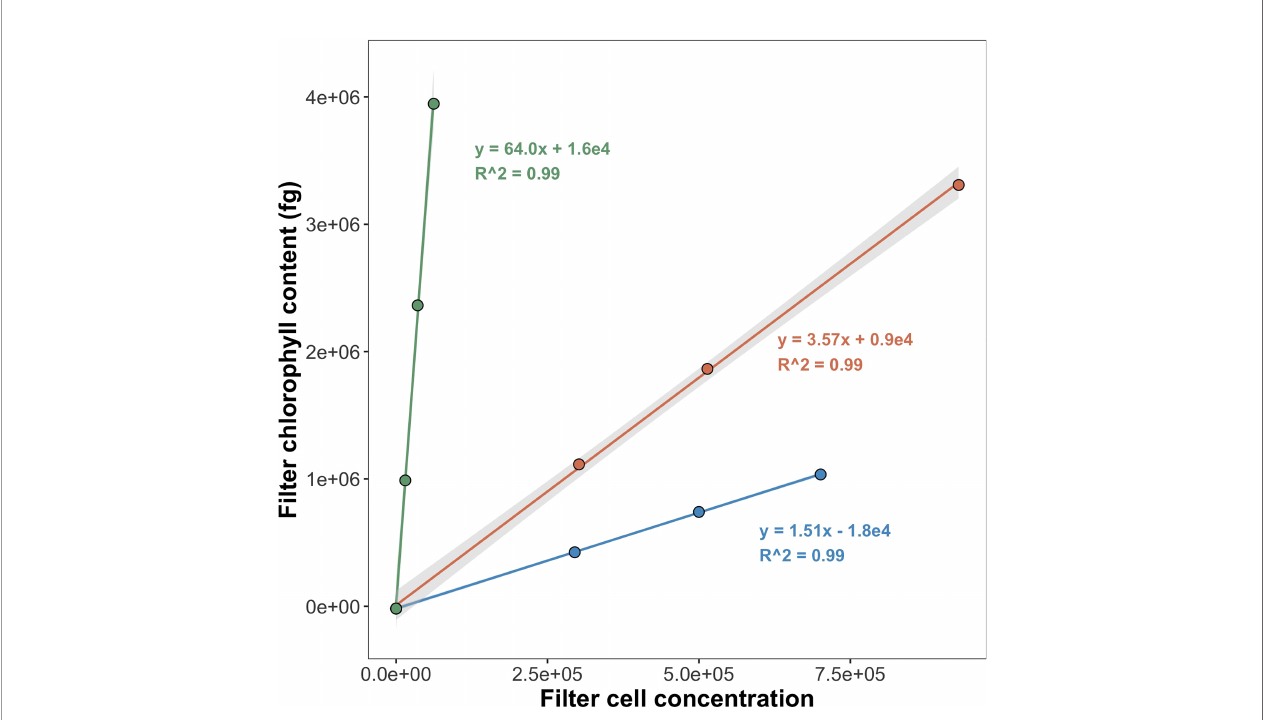
FIGURE 2 | Regressions to calculate per-cell Chl a for Prochlorococcus (PRO), Synechococcus (SYN), and picophytoeukaryotes (PPE). Samples collected from surface at EN642 station 14. Grey shading shows ± 1 standard error of regression coef fi cients (standard error values for Prochlorococcus and picophytoeukaryotes are too small to be seen). Regression slopes correspond to fg Chl a cell -1